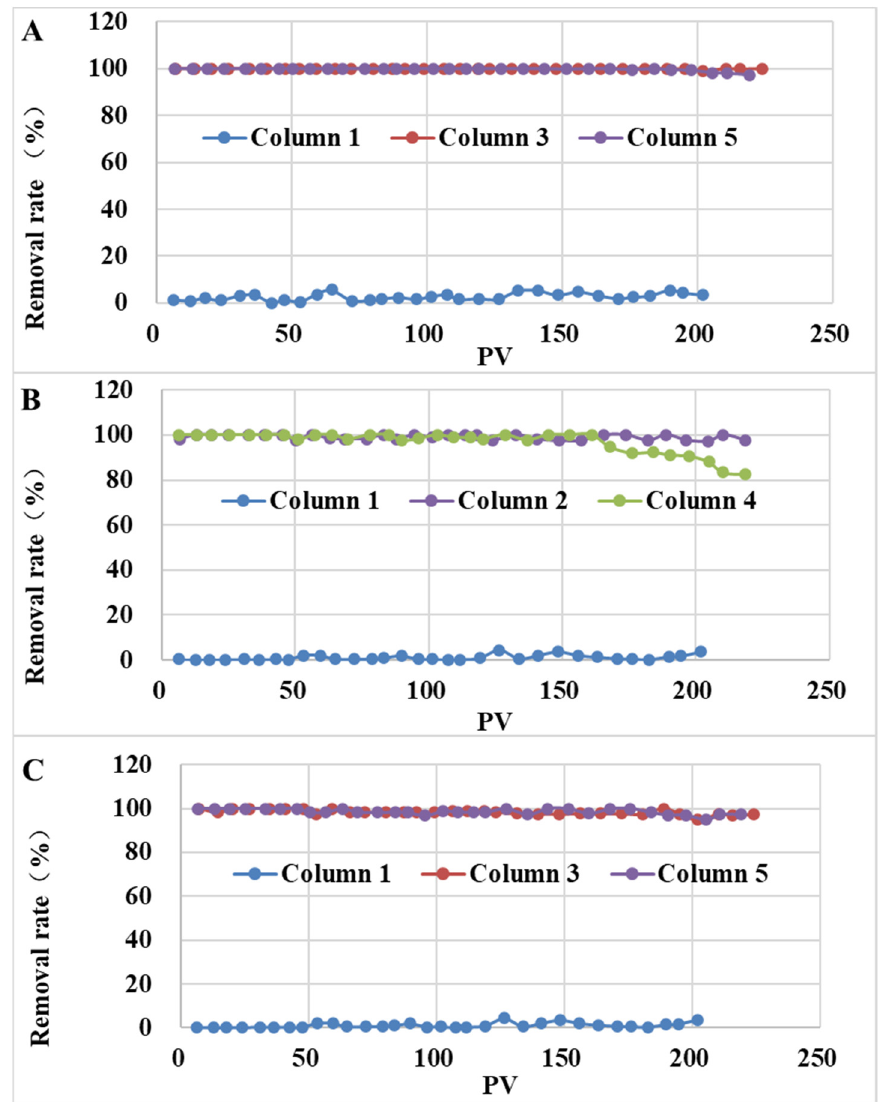
Figure 6. The removal rates of each experimental column (( A ): SMX; ( B ) and ( C ): TMP).